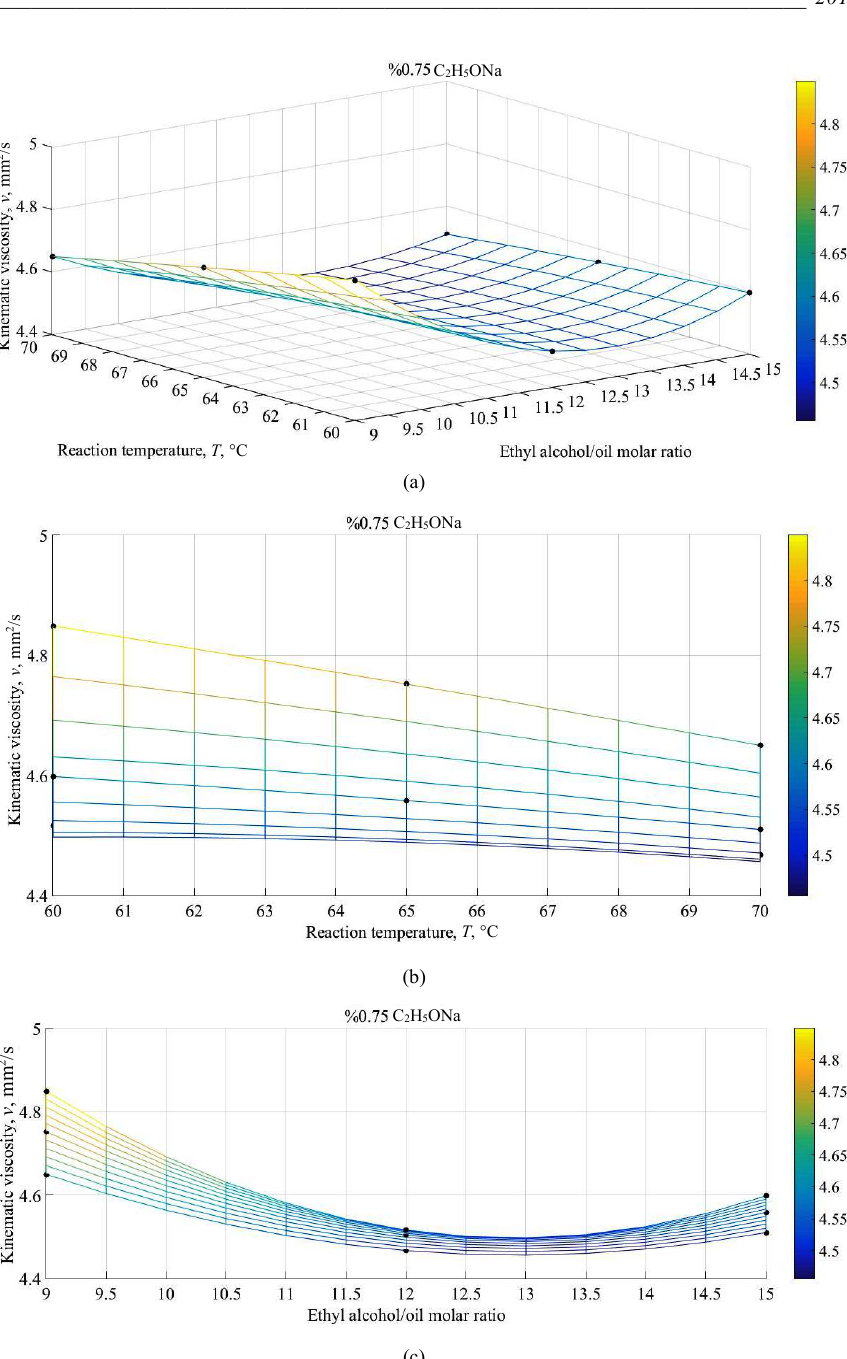
Fig. 4. Variation in ethyl ester viscosity (a) vs. reaction temperature and alcohol/oil molar ratio simultaneously; (b) alcohol/oil molar ratio; (c) reaction temperature for the catalyst concentration of 0.75